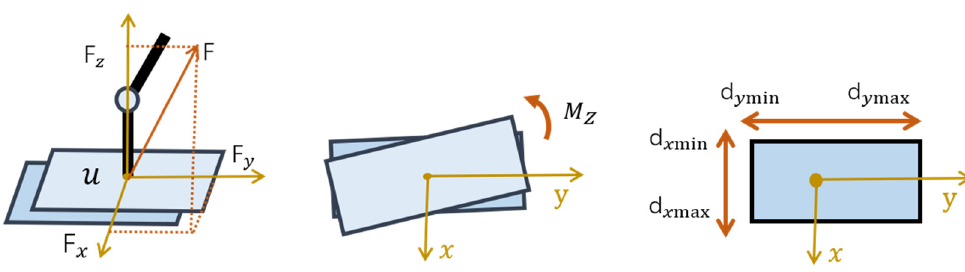
Figure 5. Friction and support region constraints.